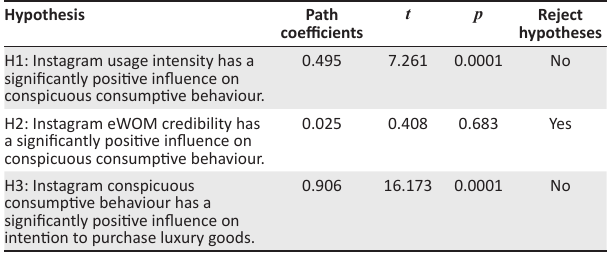
FIGURE 2: Structural model. TABLE 4: Relationship between Instagram conspicuous consumptive behaviour and intention to purchase luxury goods. t p Reject Hypothesis Path coefficients